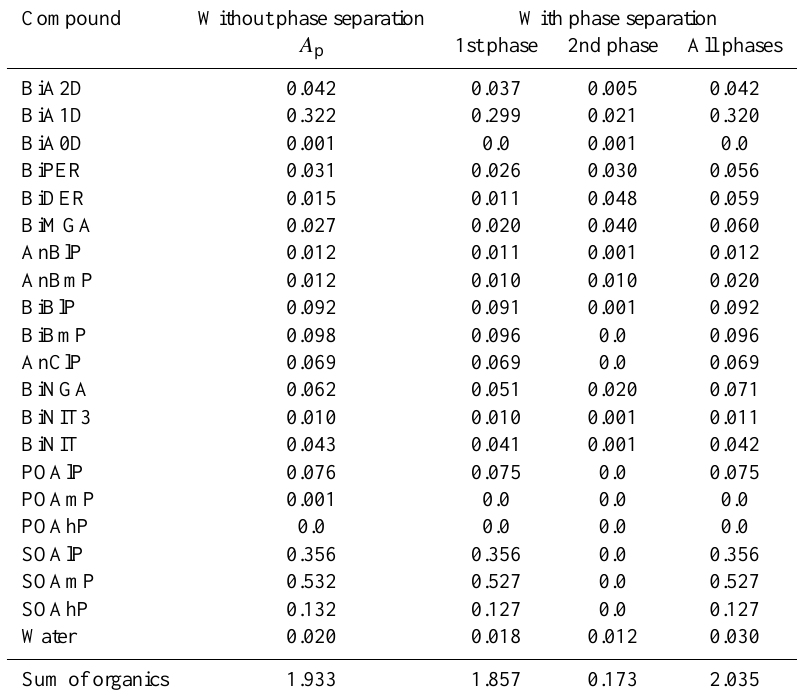
Table 9. Concentrations (in µgm − 3 ) with or without phase separation for the biogenic test case at RH = 30%.